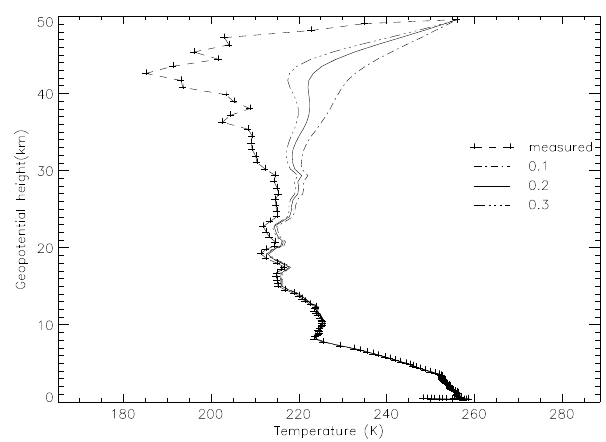
Fig. 7. The sensitivity of the temperature retrievals to the assumed background error levels for σ b = 0 . 1 × α b , σ b = 0 . 2 × α b and